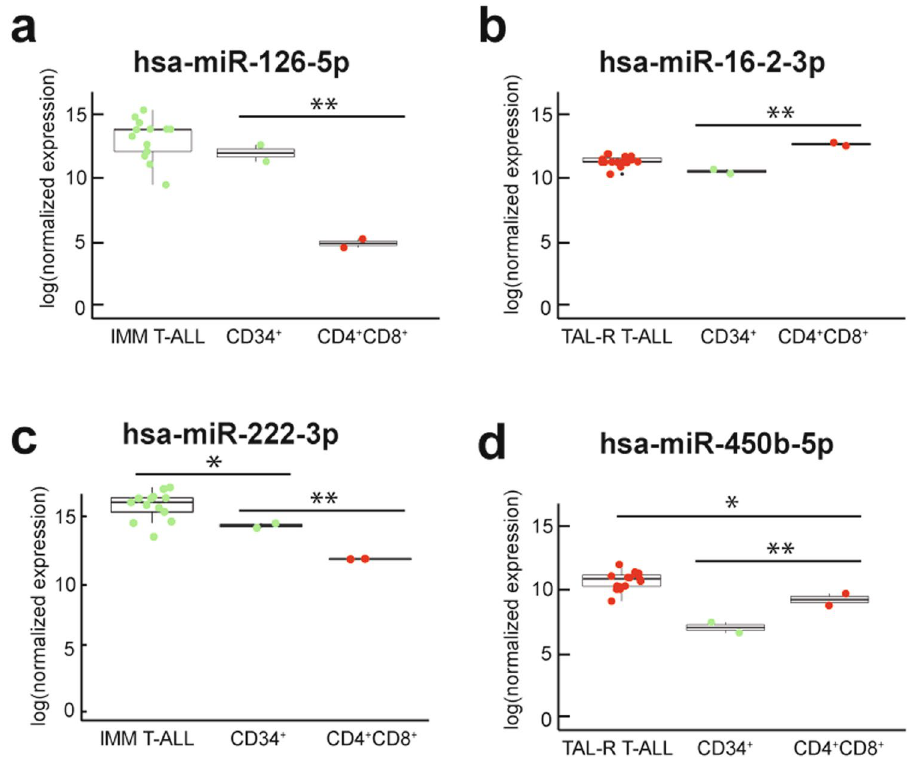
Figure 4. Subtype specific miRNAs can be either oncogenic or representative for the differentiation arrest of lymphoblasts. ( a + c ) Box plots showing the expression of the immature T-ALL specific miRNAs hsa-miR- 126-5p and hsa-miR-222-3p in the immature T-ALL patients and the thymocyte subsets. ( b + d ) Box plots showing the expression of the TAL-R T-ALL specific miRNAs hsa-miR-16-2-3p and hsa-miR-450b-5p in the TAL-R T-ALL patients and the thymocyte subsets. * Significant difference with an adjusted p-value < 0.05; ** significant difference with an adjusted p-value <